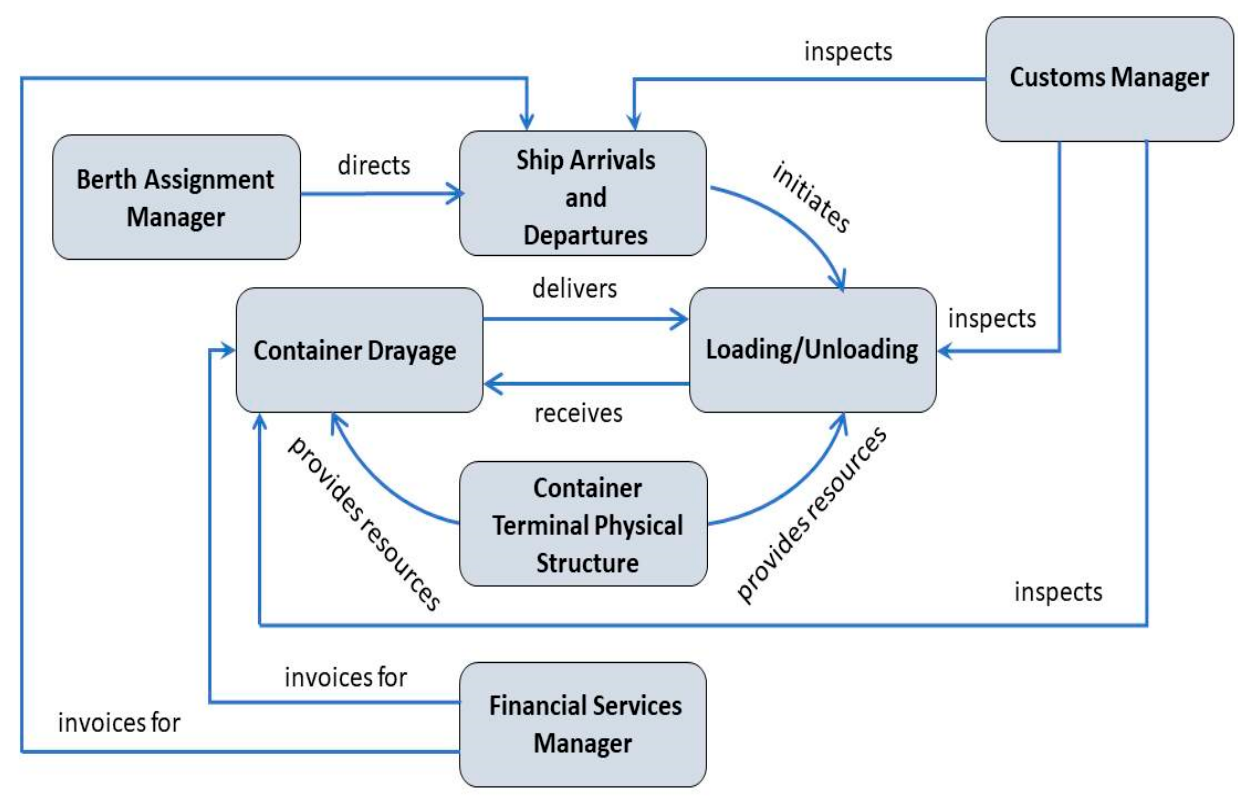
Figure 4. Relationship of cargo port pa tt erns.